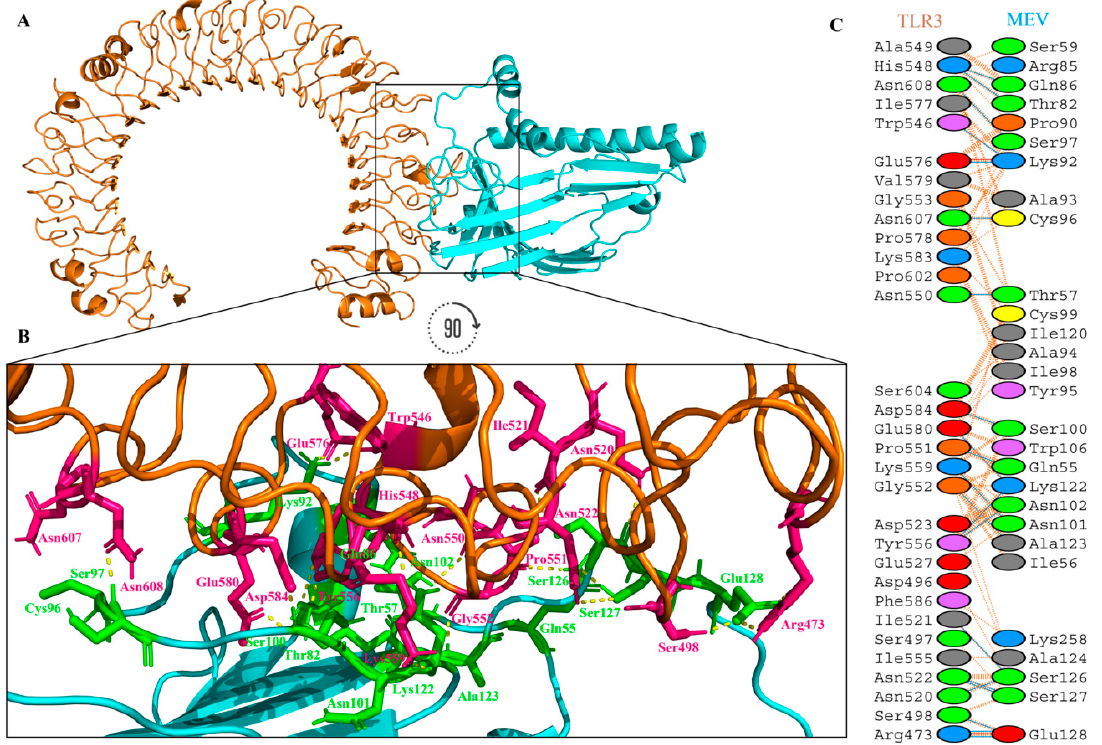
Figure 8. MEV construct docking with human TLR3: ( A ) TLR3-MEV docked complex in cartoon representation. TLR3 displayed with orange-brown color and MEV vaccine construct displayed with cyan color; ( B ) interacting residues illustration between MEV and TLR3 complex. Interacting residues of MEV are highlighted with green color stick representation, while interacting residues of TLR3 are highlighted with hot-pink color stick representation. Hydrogen bonds are represented with yellow color dotted lines; ( C ) All interacting residues of MEV and TLR3. Hydrogen bonds are shown with blue color lines, salt bridges are shown with red color lines and other contacts are shown with orange color lines. The colors of interacting residues are representing properties of amino acids (positive: blue, negative: red, neutral: green, aliphatic: grey, aromatic: pink, Pro&Gly: orange and Cys: yellow).